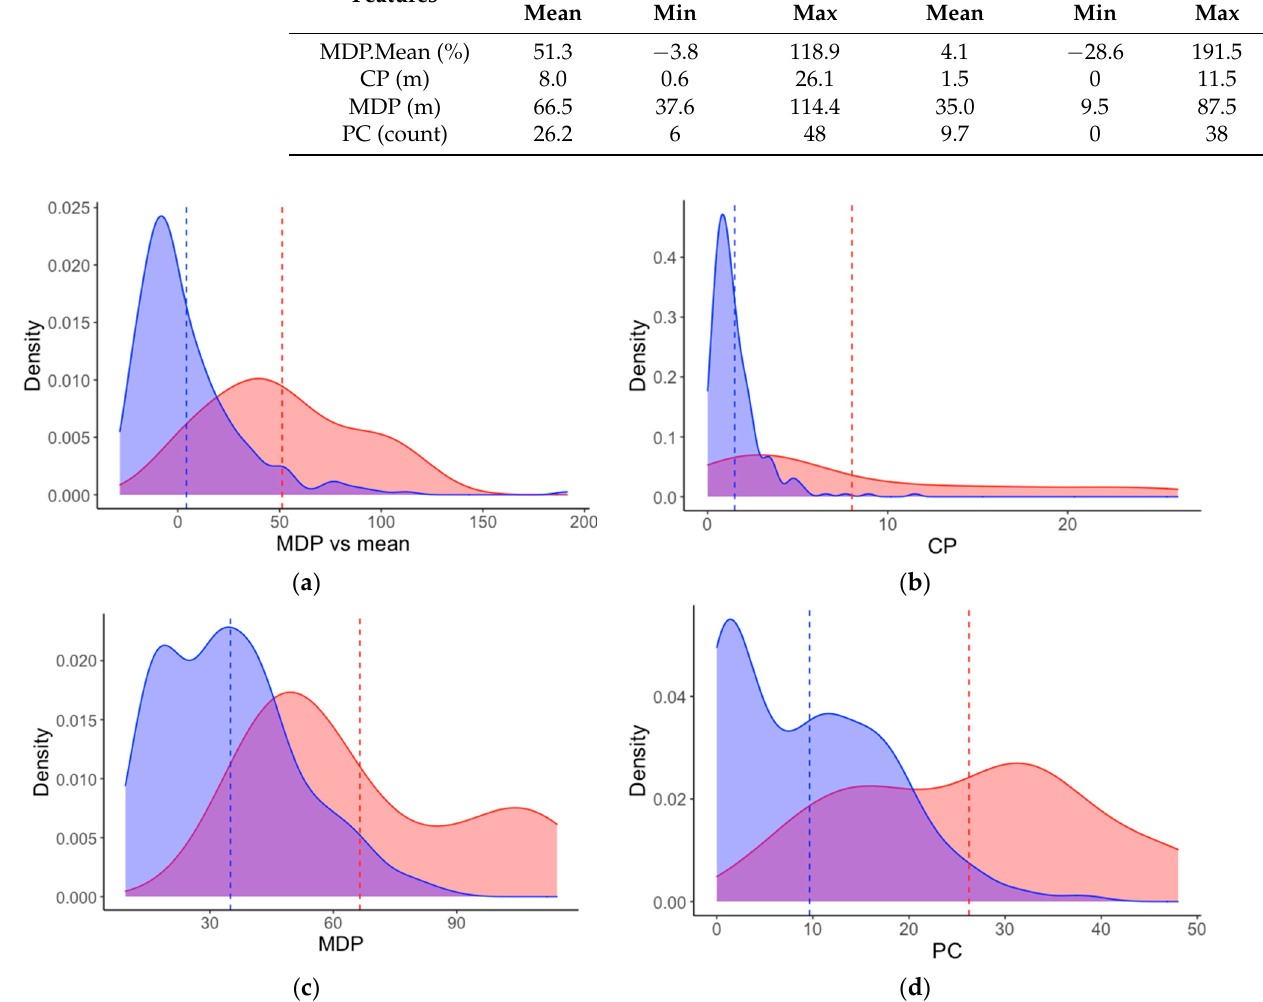
Figure 2. Density plots of the four most important features (determined by ROC curve analysis) for differentiation between lambing (red) and non-lambing (blue) animals using the training dataset (from Trial One). Features are: ( a ) MDP.Mean— Mean of mean distance to peers (for all peers); ( b ) CP—closest peer (for individual animal); ( c ) MDP—mean distance to peers (for individual animal); ( d ) PC—posture change (for individual animal). Mean lines are also shown (lambing: red dashed line; non-lambing: blue dashed line). The key characteristics of all features are the higher mean values and wider distributions when sheep are lambing. Table 3. Summary statistics for the top four features of the training (Trial One) dataset (deter- mined by ROC curve analysis).